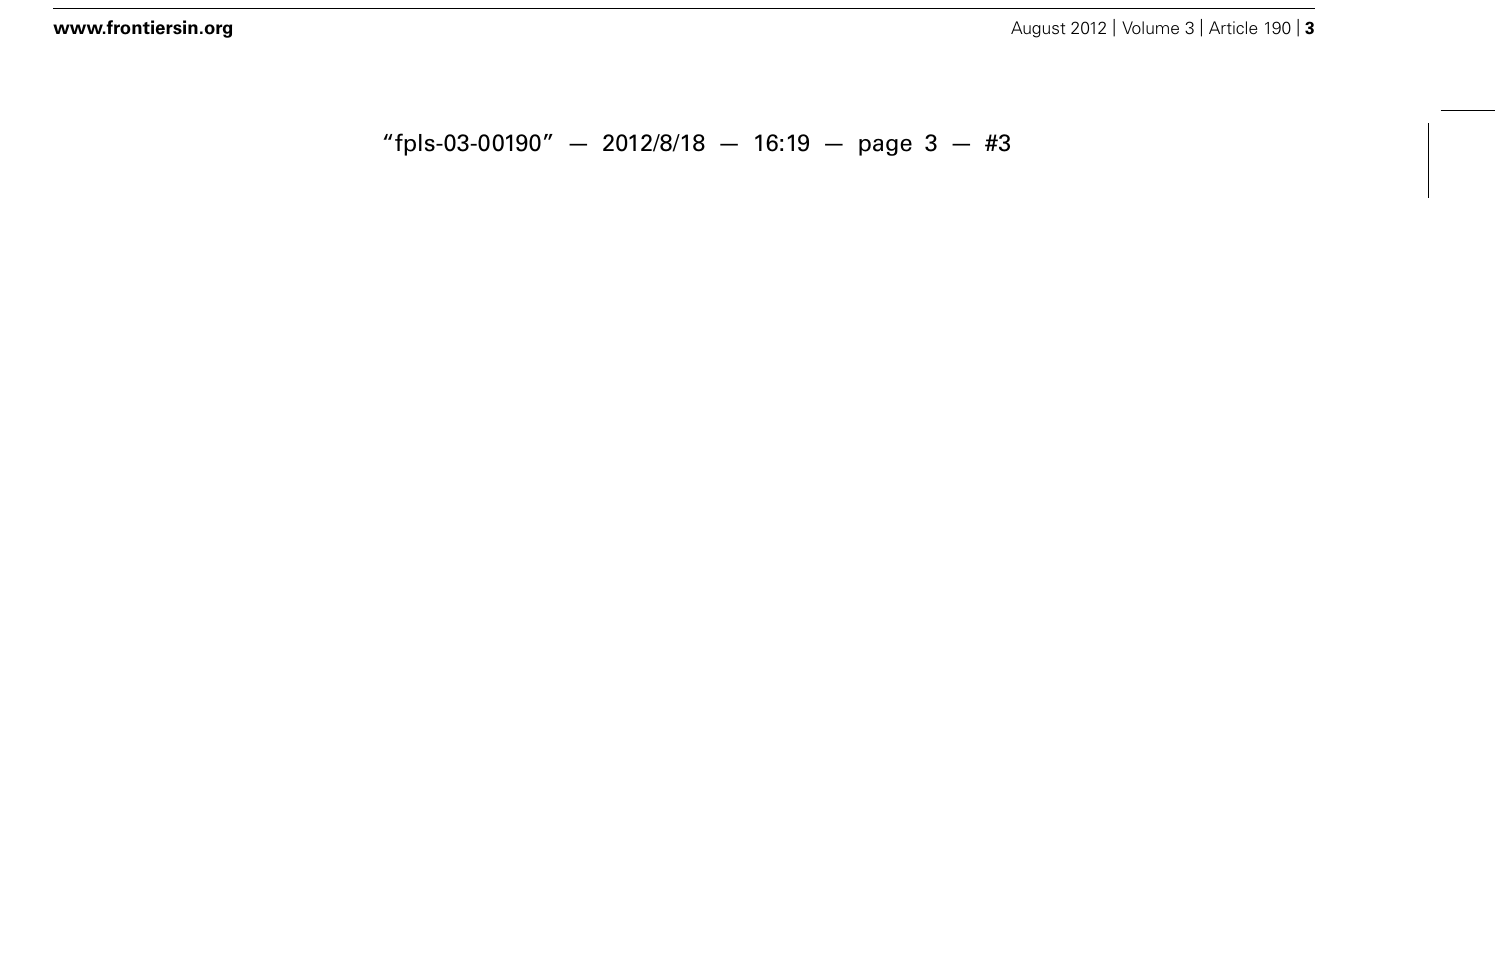
in the left image.The consensus 14-3-3 amino acid sequence is color-coded according to the degree of conservation determined with ConSurf (bottom panel). Residues predicted to have roles in 14-3-3 structure (conserved and buried) and function (conserved and exposed) are annotated below the sequence. Exposed and buried residues were determined using a neural network algorithm. Residues for which there was insufficient data (present in less than 10% of isoforms) are indicated in yellow. Positions of the nine alpha-helices are indicated below the